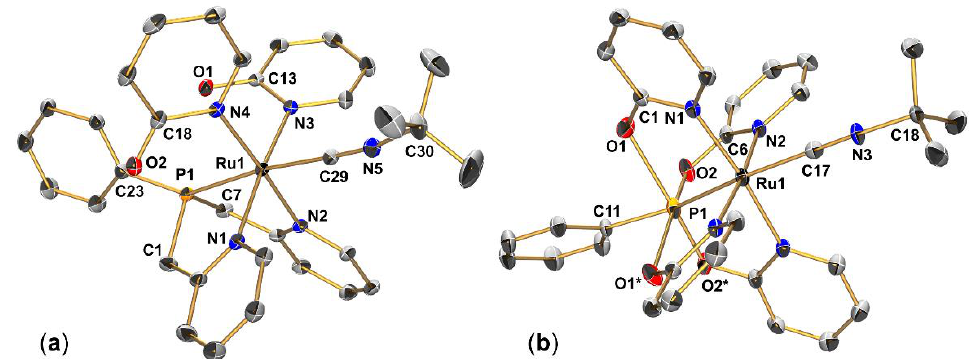
Figure 5. ( a ) Molecular structure of 5a in the crystal structure of 5a · 1.5(CH 2 Cl 2 ) (thermal displacement ellipsoids drawn at the 30% probability level, selected atoms labeled, H-atoms and solvent molecules are omitted for clarity), selected interatomic distances (Å) and angles (deg.) of 5a : Ru1–P1 2.3080(4),